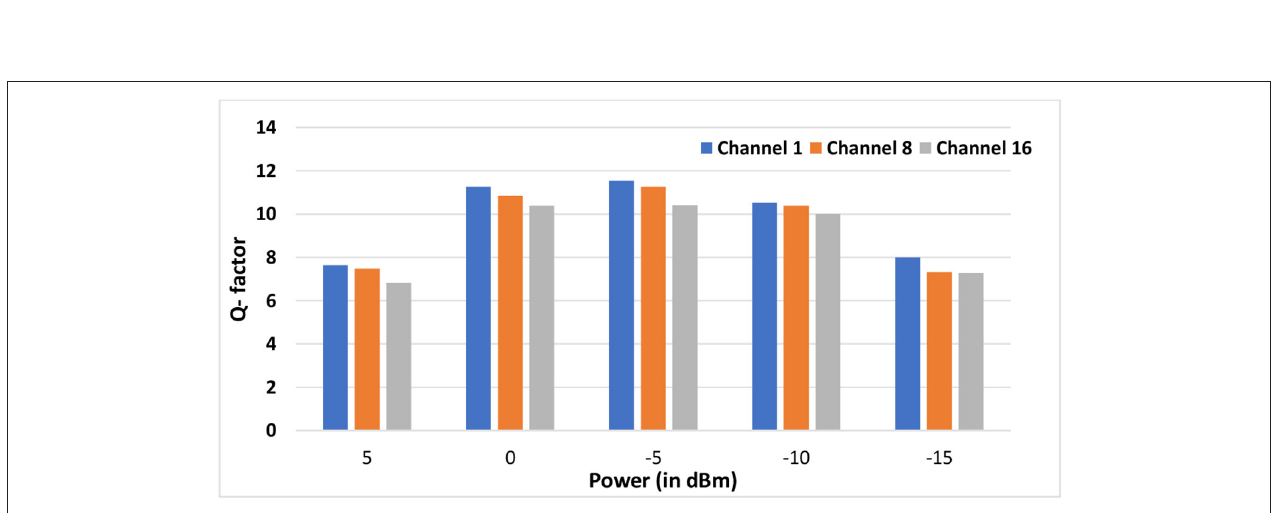
FIGURE 9 | Variation of Q factor with power at channel spacing of 50